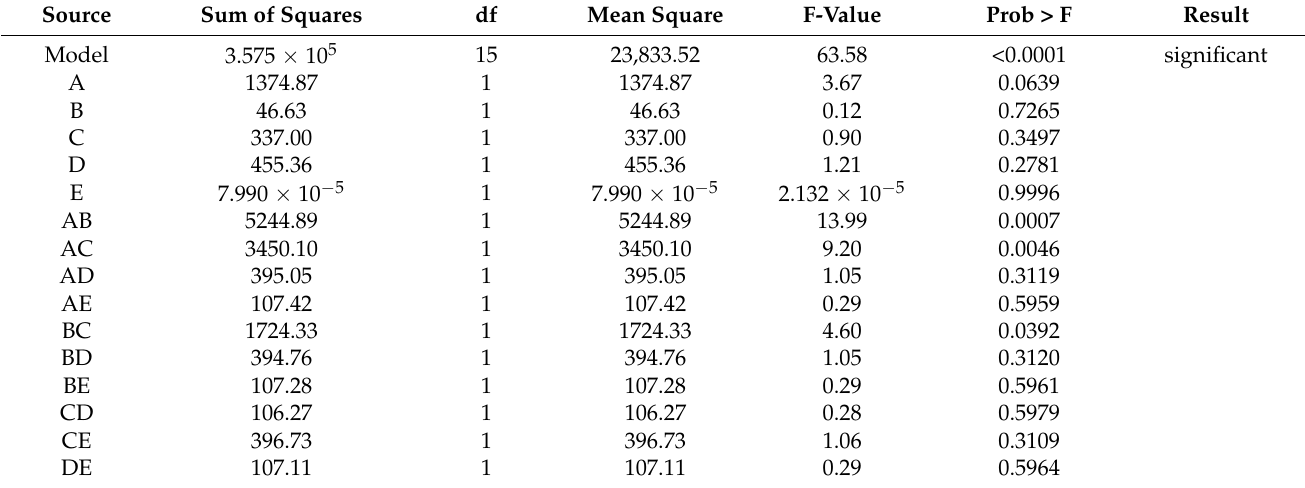
Table 6. Significance test of the sliding friction work regression model.